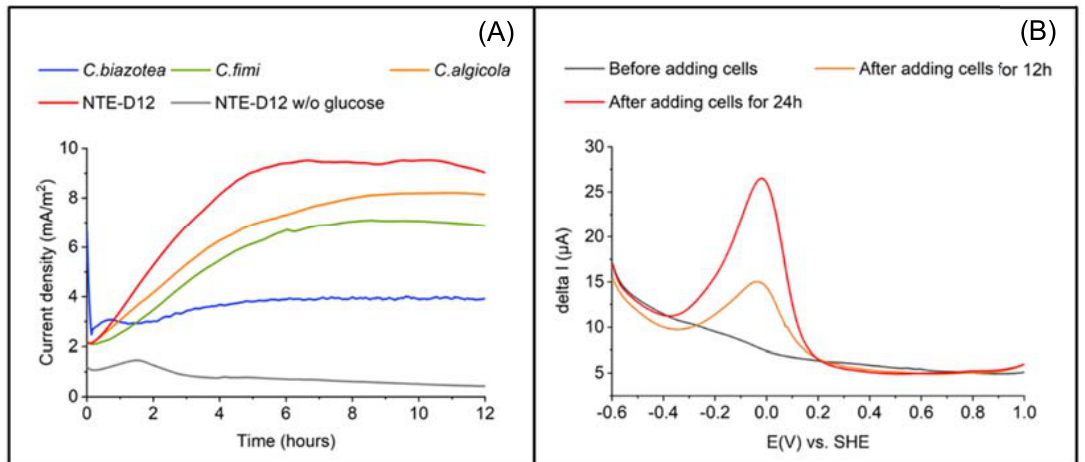
Figure 3. ( A ) Comparison of current production among four strains ( C. biazotea , C. fimi , C. algicola, and strain NTE-D12) using carbon electrode as a working electrode. ( B ) Differential pulse voltammograms of strain NTE-D12 before and after adding cells for 12 and 24 h using ITO electrode as a working electrode.